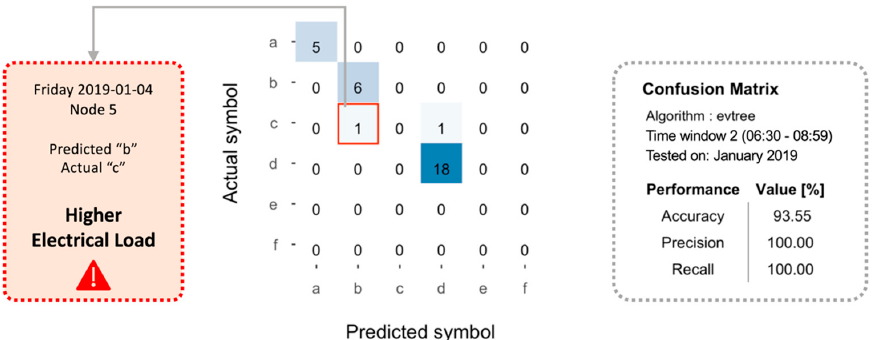
Figure 14. Confusion matrix for the globally optimal classification tree predicting January 2019 total electrical load symbol in the 2nd time window. Red square: the detected anomalous